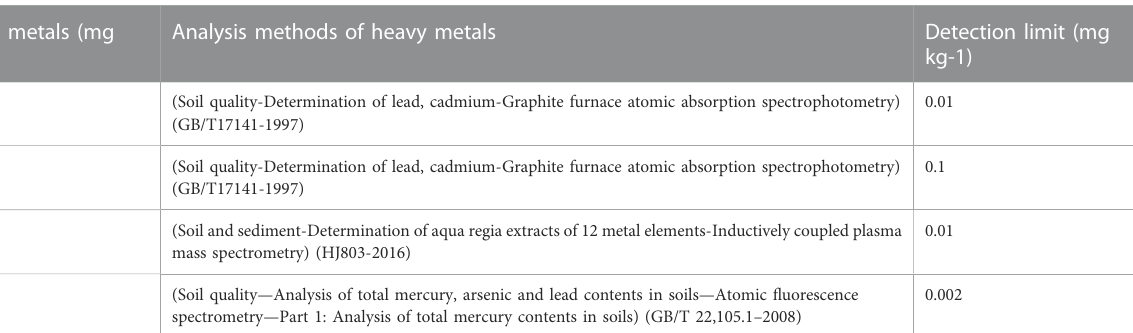
TABLE 1 Analysis methods and detection limit of heavy